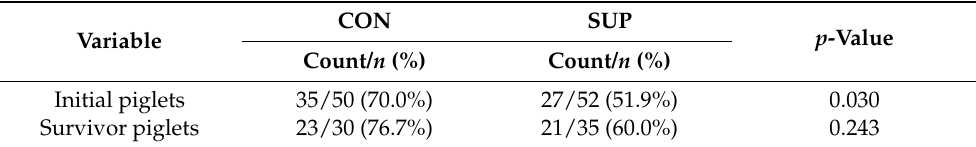
Table 7. Percentages of injectable antibiotic treatment for piglets under Q1 (1.100 kg) in CON and SUP groups. Data are count/n; percentages are shown in brackets. CON: control group; SUP: colostrum supplemented group. Comparisons between groups were made by using Pearson’s Chi-squared test.